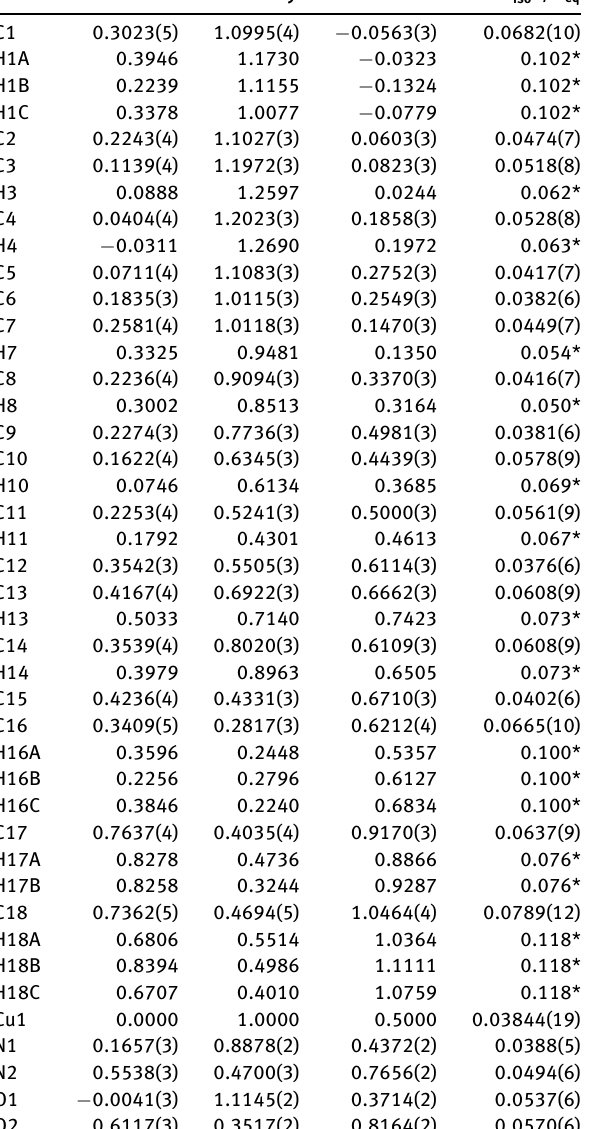
Table 2: Fractional atomic coordinates and isotropic or equivalent isotropic displacement parameters (Å 2